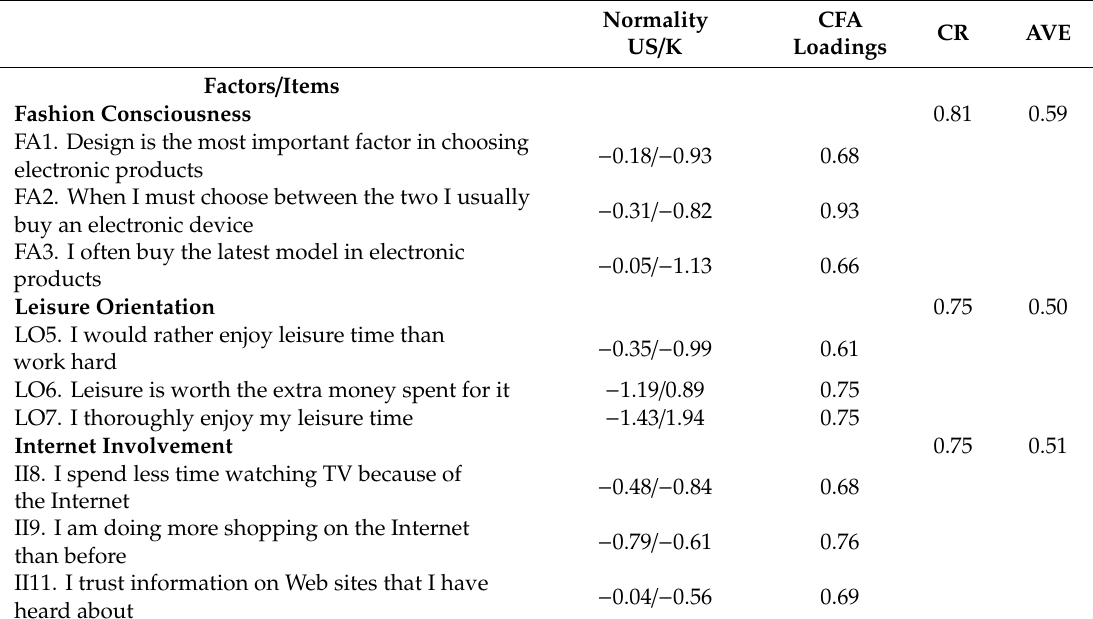
Table 1. Normality (univariate skewness and kurtosis), factor loadings in confirmatory factor analysis (CFA), composite reliability (CR), and average variance extracted